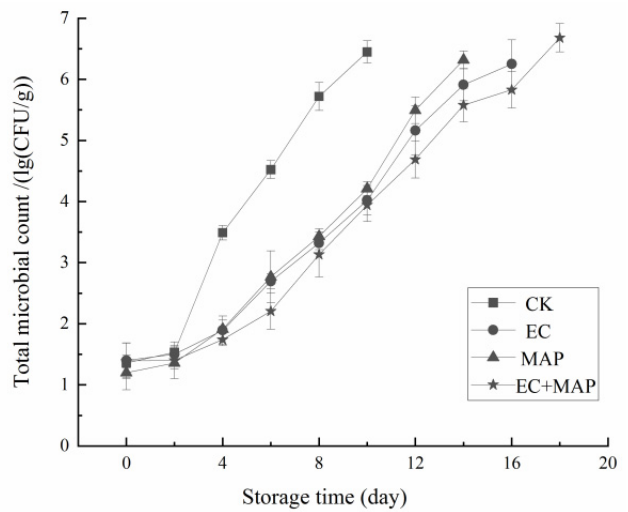
Figure 6. Effect of different treatments on total number of microorganisms of fresh-cut pineapples during storage.